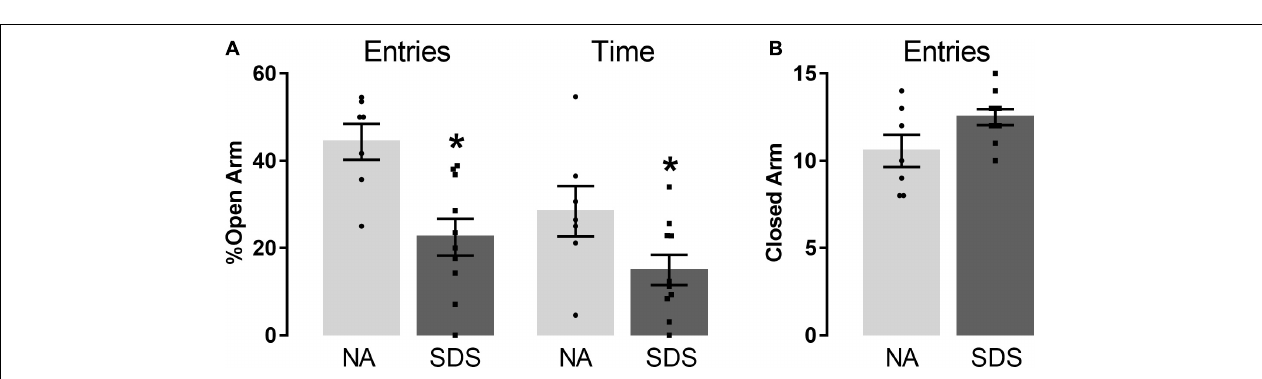
FIGURE 1 | Chronic SDS induces social avoidance-like behavior in mice. (A) SDS mice ( n = 15) spend less time in the interaction zone (IZ) with a nonfamiliar target compared with the NA interaction mice ( n = 9). (B) Time spent in the corner zone (CZ) in the absence and presence of the target. (C) Social interaction ratio in the IZ and CZ. Bars with scatter dot plot represent mean ( ± SEM). * p < 0.05 compared with the No target of the respective group or to the NA group. NA, non-aggressive; SDS, social defeat stress.